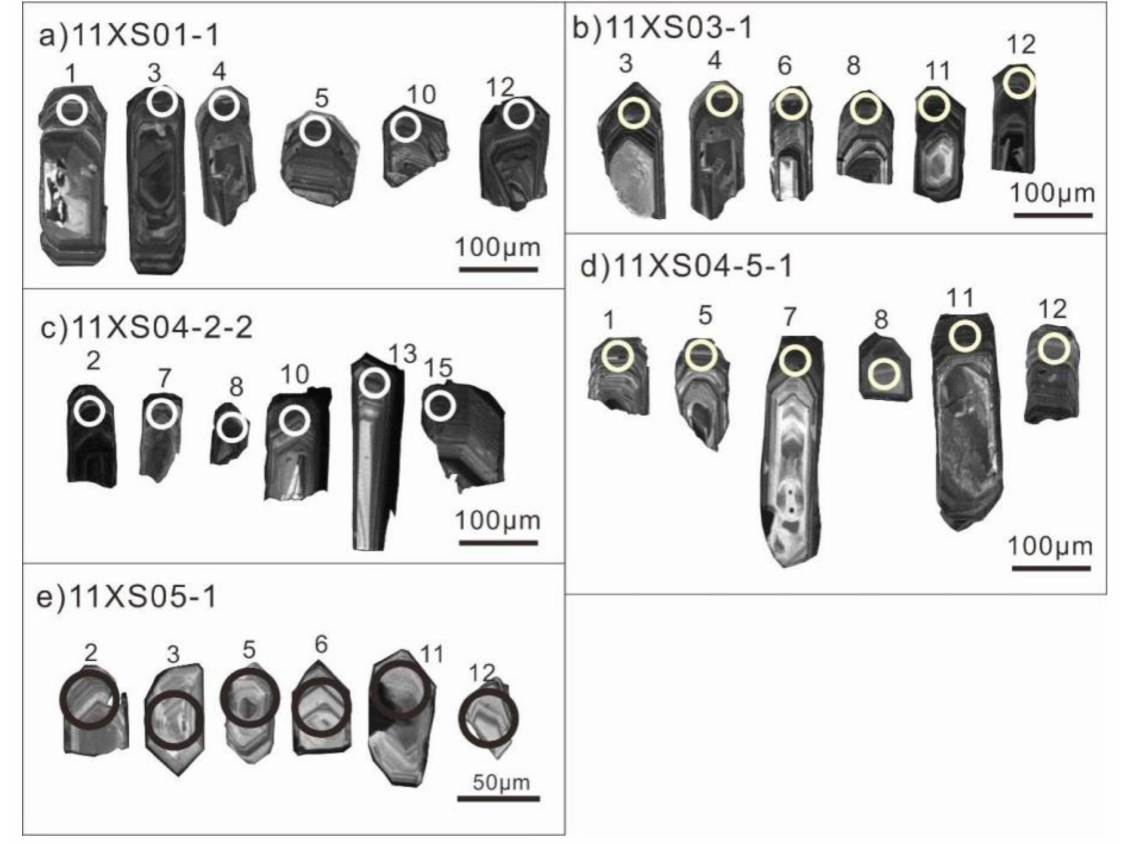
Figure 3. Cathodoluminescence images for typical zircons from the Guiping complex: ( a ) sample 11XS01-1, ( b ) sample 11XS03-1, ( c ) sample 11XS04-2-2, ( d ) sample 11XS04-5-1, and ( e ) sample 11XS05-1.Analyzed spot on zircon grains is marked by a hollow circle and corresponding serial